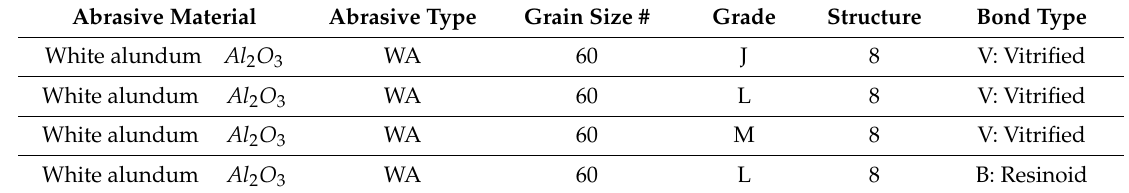
Table 2. Specifications of grinding wheels